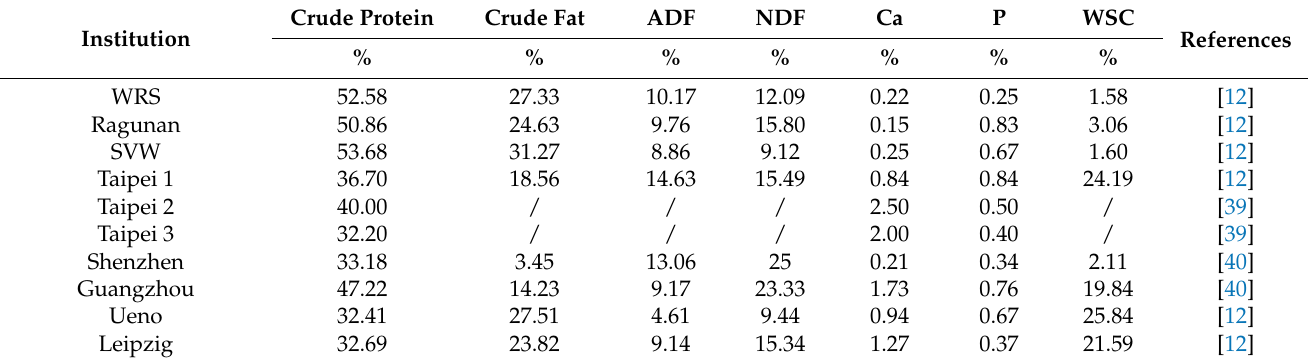
Table 2. Nutrient concentrations of each institution’s diets on a dry matter